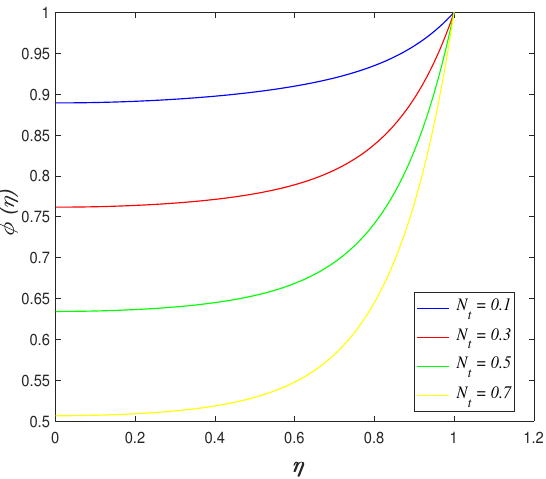
Figure 22. Impact of N t on